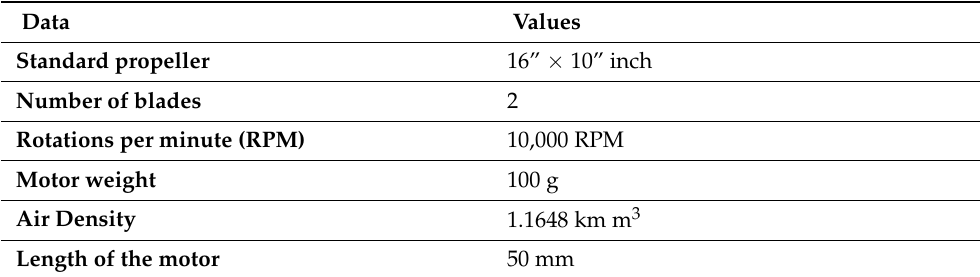
Table 4. Values used to calculate the static thrust.